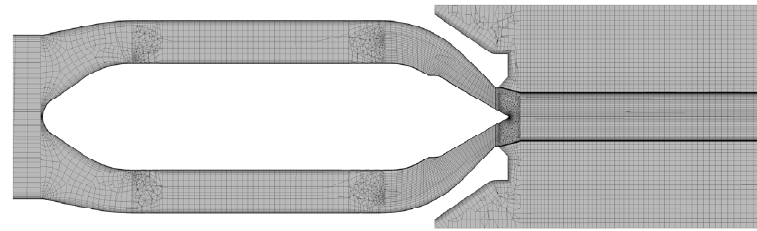
Figure 4. Mesh of the nozzle and jet area.